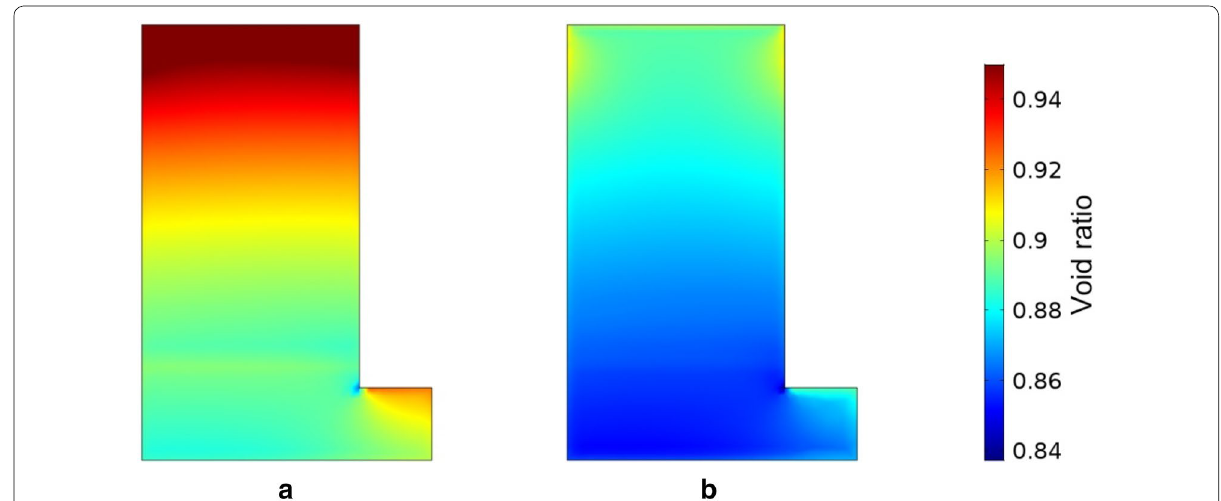
Fig. 21 Spatial distribution of void ratio of CPB under different drainage conditions after 7-days of curing: a undrained CPB; b drained